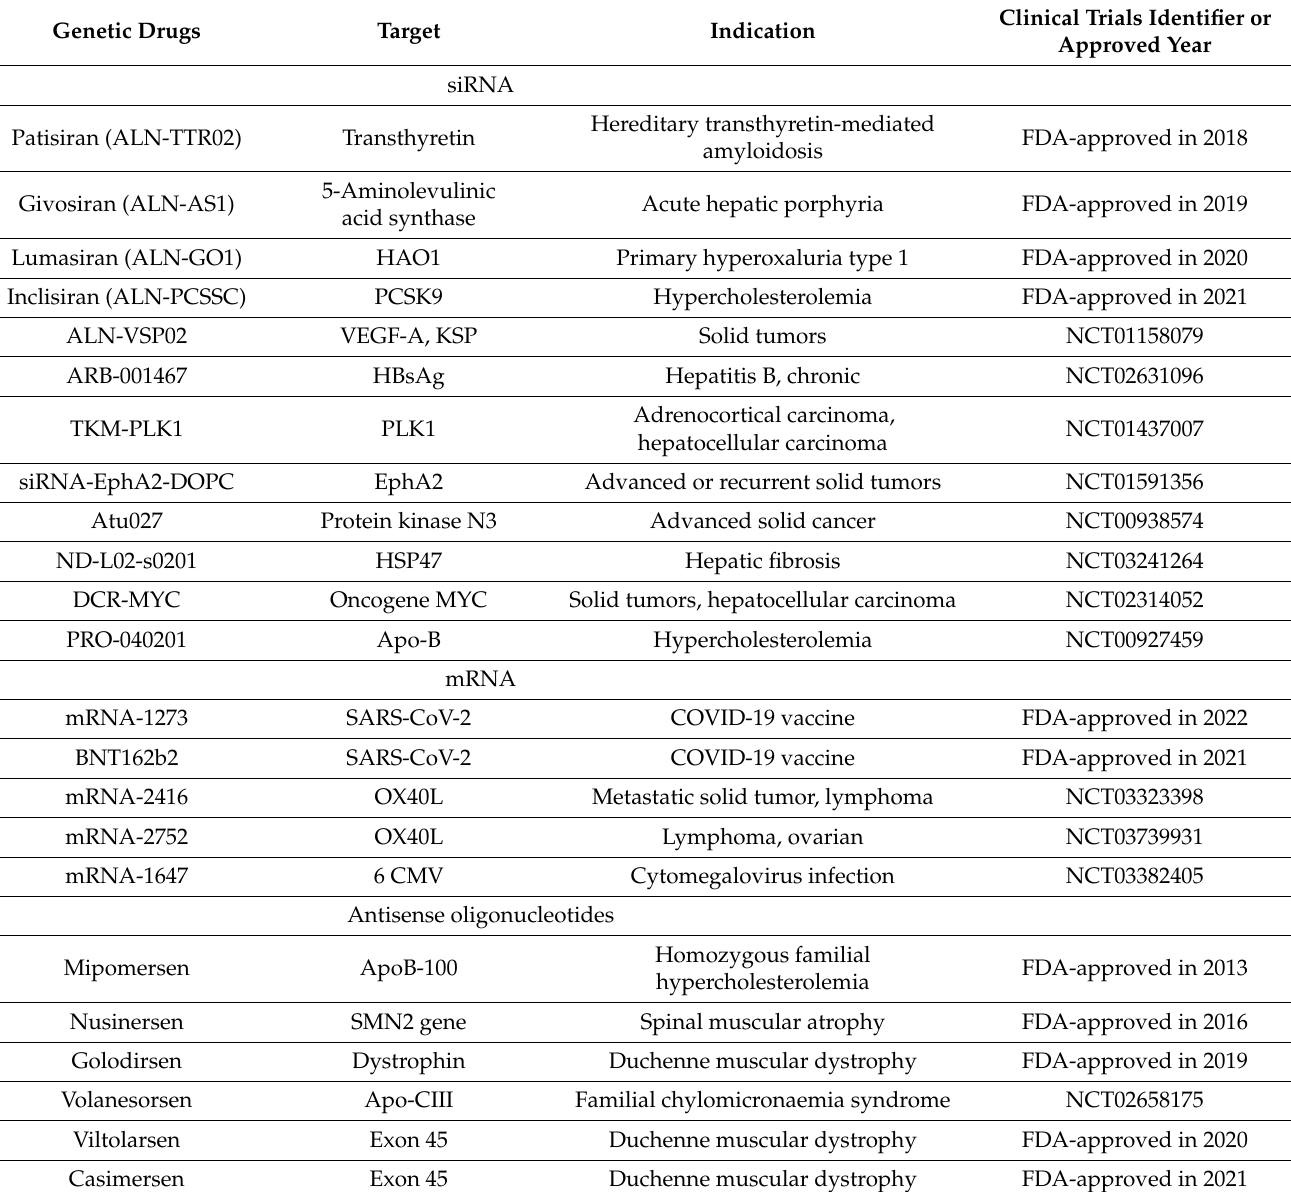
Table 1. Representative of FDA-Approved RNA Agents for Clinical Use. Genetic